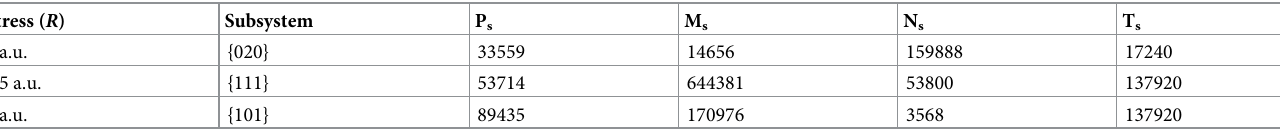
Table 3. Protein levels in the